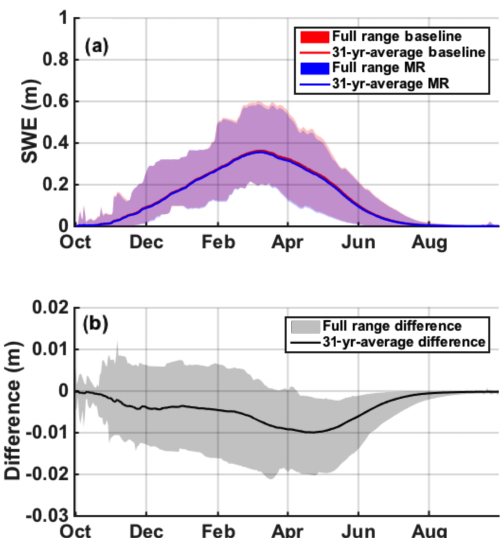
Figure 9. (a) Daily time series of basin-averaged posterior SWE from WY 1985 to WY 2015. The 31-year averages are displayed in solid lines, while the shaded regions represent the full range across WYs. (b) The 31-year-averaged difference between the MR case and the baseline is displayed in black, with the full range of differ- ences shaded in grey.